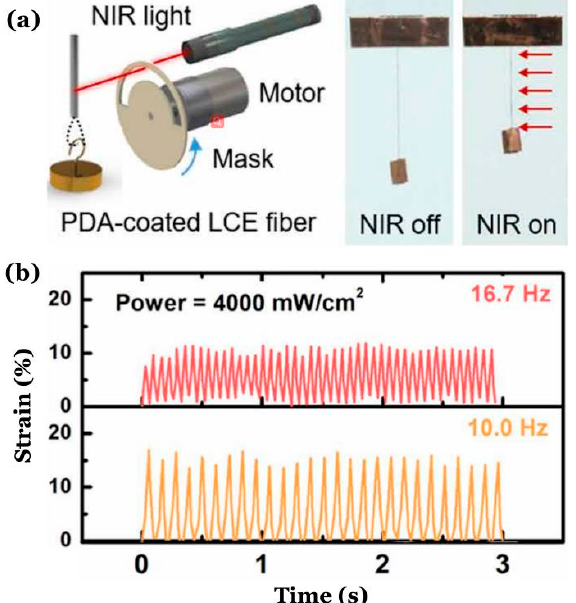
Figure 1. Periodic oscillation of an LCE fiber with a mass block in a periodic illumination [10]. ( a ) Schematic diagram; ( b ) dependence of the strain of LCE fiber against time for two different frequencies of illumination.